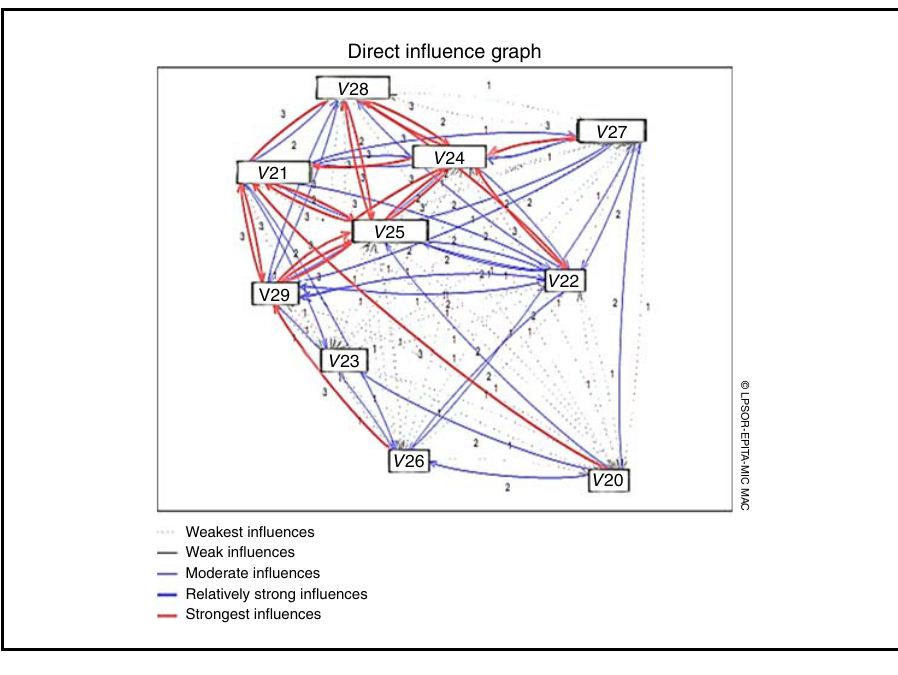
Figure 8 Sociocultural positive influence relations